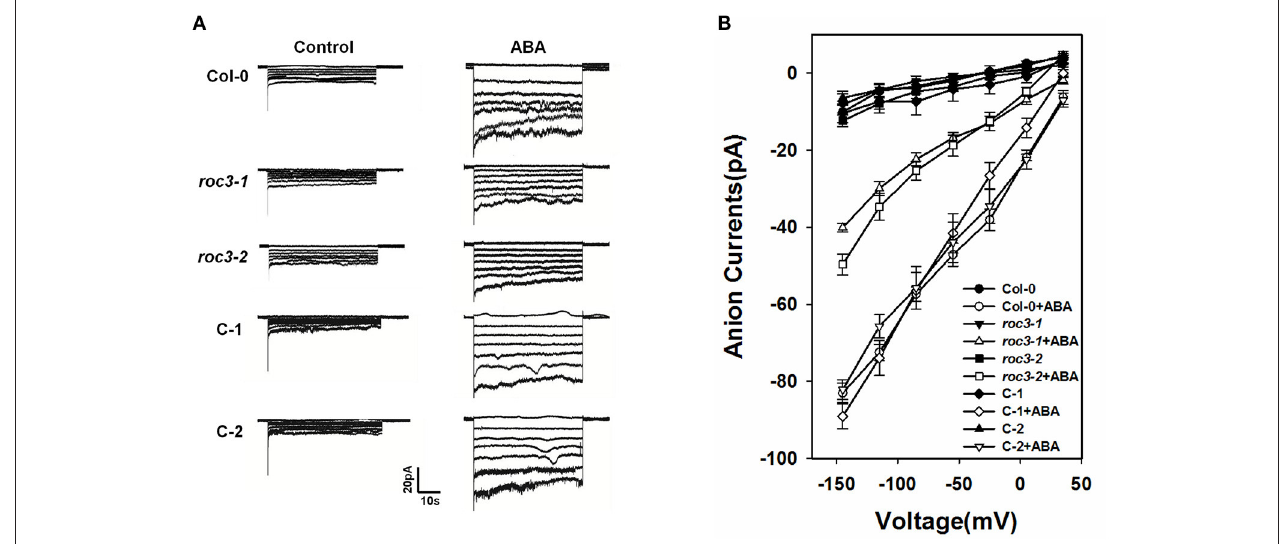
FIGURE 4 | ROC3 is involved in the ABA-induced activation of anion channels in guard cells. (A) Patch-clamp whole cell recordings of S-type anion currents present in guard cell protoplasts isolated from WT, roc3 mutants and the C-1 and C-2 complementation lines, incubated in the presence/absence of 50 µ M ABA. (B) Average current-voltage relationships of whole cell S-type anion currents. The number of guard cells measured were: WT (5), WT + ABA (6), roc3-1 (4), roc3-1 + ABA (6), roc3-2 (5), roc3-2 + ABA (6), C-1 (4), C-1 + ABA (6), C-2 (4), C-2 + ABA (5). Values shown in the form mean ±